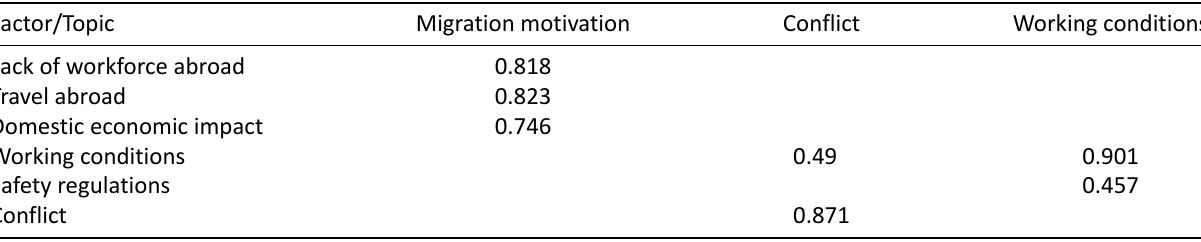
Table 2. Factor loading for topics based on principal component extraction with Oblimin rotations.